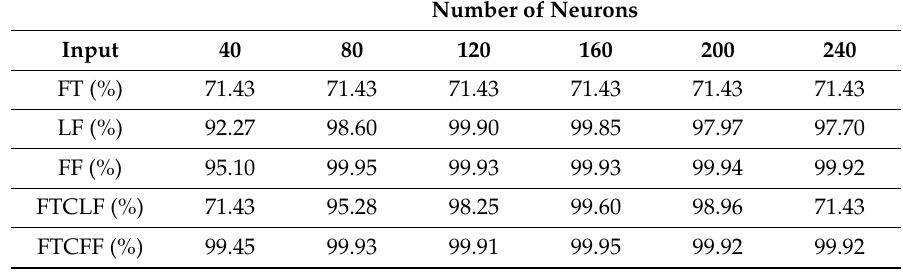
Table 3. Accuracy results of the test set (content: accuracy).